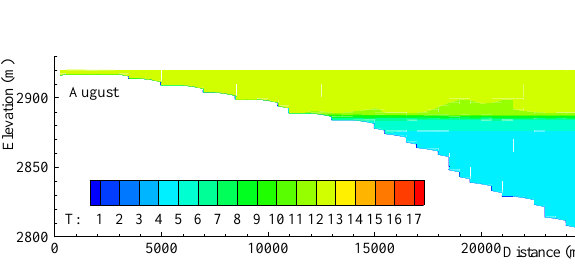
Fig. 3. The initial temperature field of Bala Reservoir ( ◦ ).